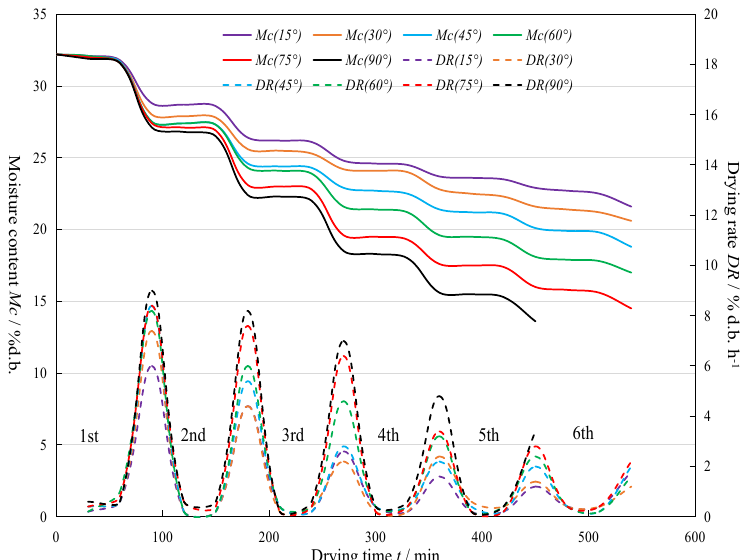
Figure 3. The variation of moisture content and drying rate with drying times for different valve